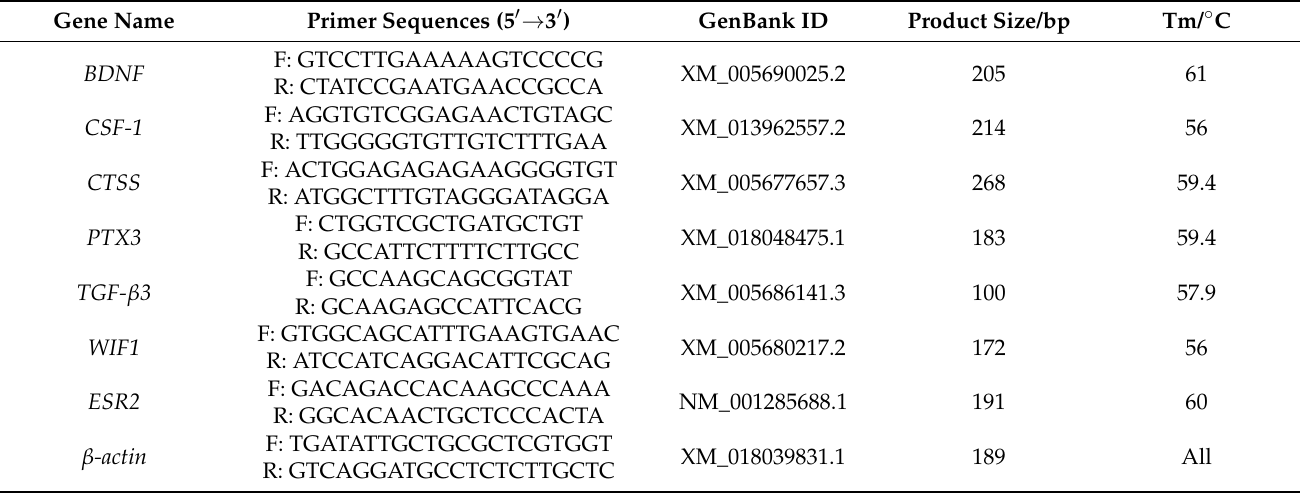
Table 2. Details of primers for RT-qPCR validation of mRNA sequencing